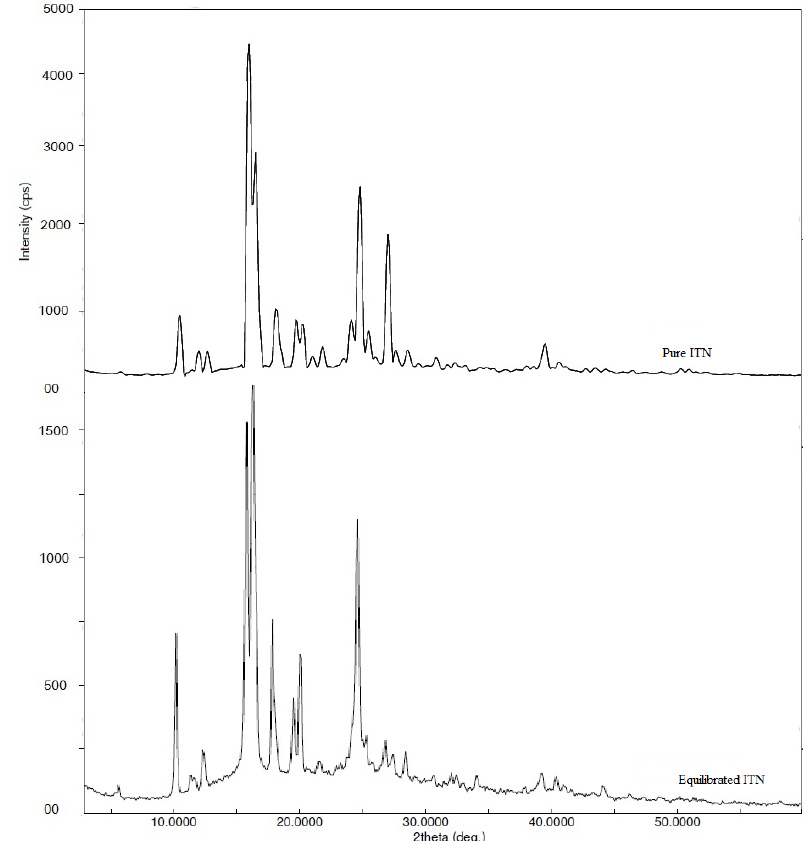
Figure 5. X-ray diffraction (XRD) patterns of pure and equilibrated ITN obtained from MeOH.